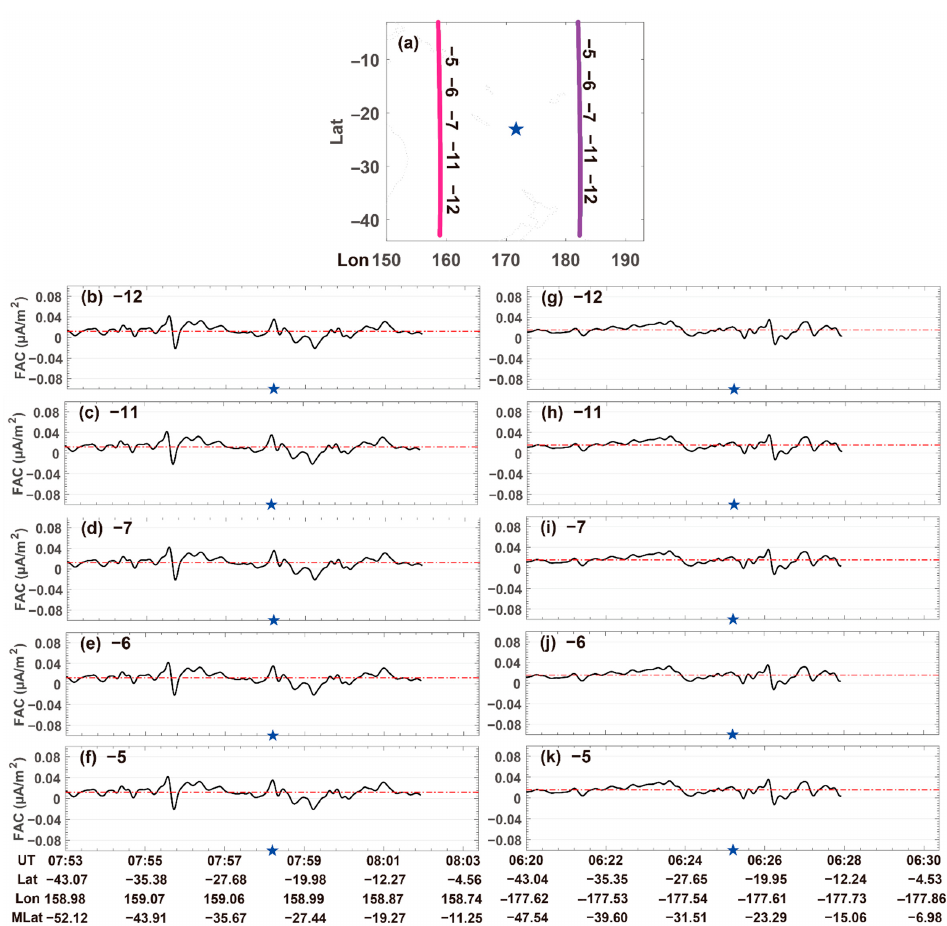
Figure 5. Field-aligned currents (FACs) in the range of 20° latitude by 20° longitude centered on the M7.7 epicenter on the disturbed days. ( a ) Tracks in this area; the blue star shows the epicenter; ( b – f ) FACs on days − 12, − 11, − 7, − 6 and − 5 along the left tracks in ( a ); ( g – k ) FACs on days − 12, − 11, − 7, − 6 and − 5 along the right tracks in ( a ). The blue star indicates the epicenter’s latitude, and the red dashed lines represent the median FACs along the corresponding tracks in the area of interest.